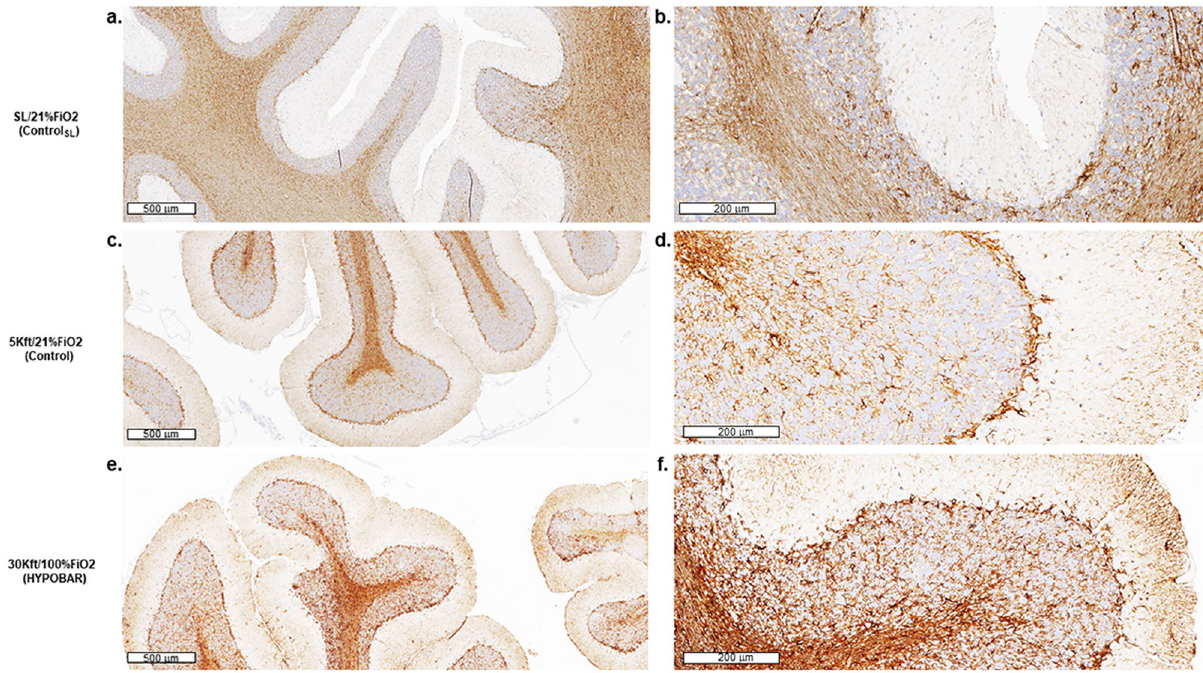
Figure 3. Immunohistochemistry (IHC) outcomes of the GFAP antibody in the left cerebellar hemisphere of minipig brains exposed to different oxemic and barometric conditions. Panel ( a ), ( c ), ( e ) show sections of the left cerebellar cortex at a lower level of magnification [at a scale of 600 microns (µm)] across all three analyzed conditions. Panels ( b ), ( d ), ( f ) show the same regions at a higher level of magnification [at a scale of 200 microns (µm)]. Note the higher astroglial response in the cerebellar “arbor vitae” of HYPOBAR vs. the other two groups. SL sea level, FiO 2 fraction inspired oxygen, HYPOBAR nonhypoxic-hypobaric condition, ft feet, ControlSL SL/21%FiO 2 , Control 5Kft/21%FiO 2